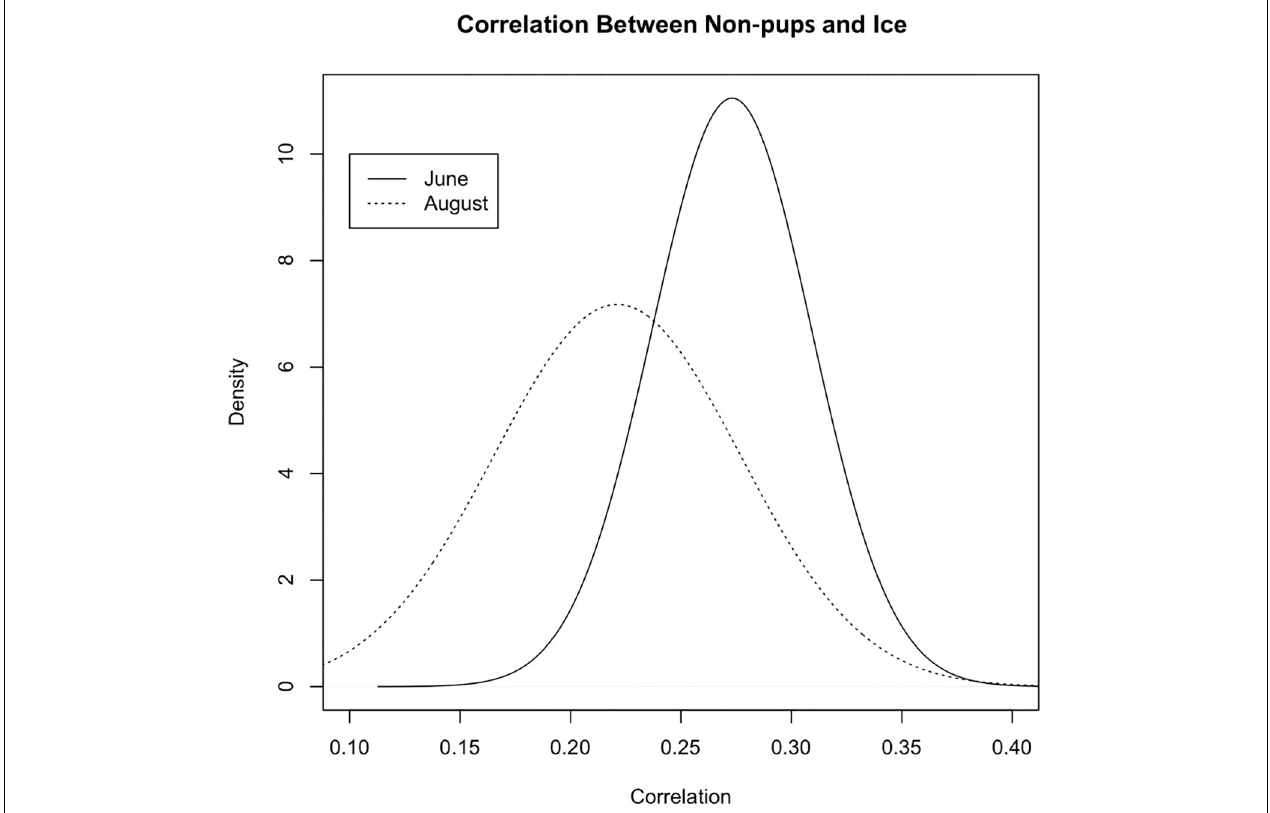
FIGURE 11 | Correlation between the standardized counts of non-pups at each site and the standardized ice proportion at each site ( (cid:51) 1 , 3 ) during the pupping period (solid line) in June and during the molting period [dashed line, ( (cid:51) 1 , 2 )] in August (2007–2014) in Johns Hopkins Inlet in Glacier Bay National Park in southeastern Alaska. Correlation values can range from –1 to